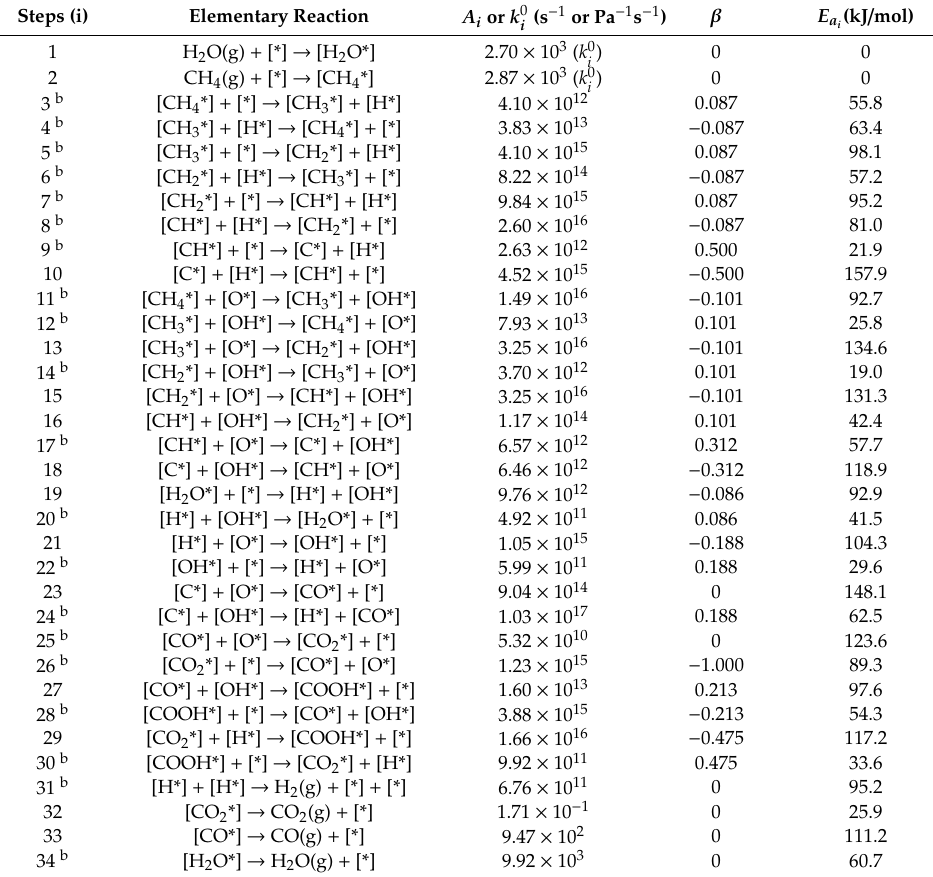
Table 1. Elementary reactions and corresponding kinetic parameters used in this work a